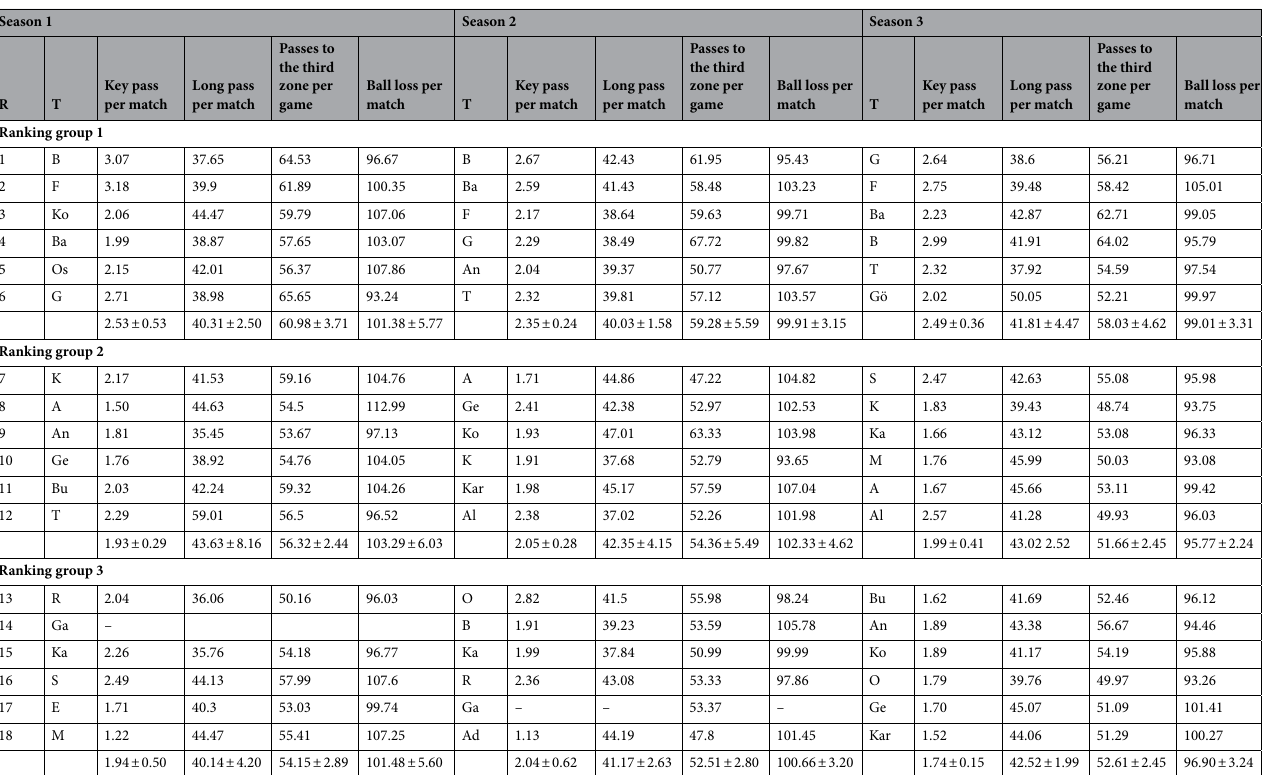
Table 3. Technical data of the player during the match [Key pass per match, long pass per match, Passes to the third zone per game (mean and SE)] as a function of Ranking group and Season Condition. Data are presented as means and standard deviations. TD: Total Distance; THID: Total high intensity running distance; TS: Total number of sprints; TSD: Total sprint distance; R: Ranking; Teams: Beşiktaş (B); Fenerbahçe (F); Konyasport (Ko); Başakşehir (Ba); Osmanlıspor (O); Galatasaray (G); Kasımpaşa (K); Akhisar (A); Antalyaspor (An); Gençlerbirliği (Ge); Bursaspor (Bu); Trabzonspor (T); Rizespor (R); Gaziantepspor (Ga); Kayserispor (Ka); Sivasspor (S);